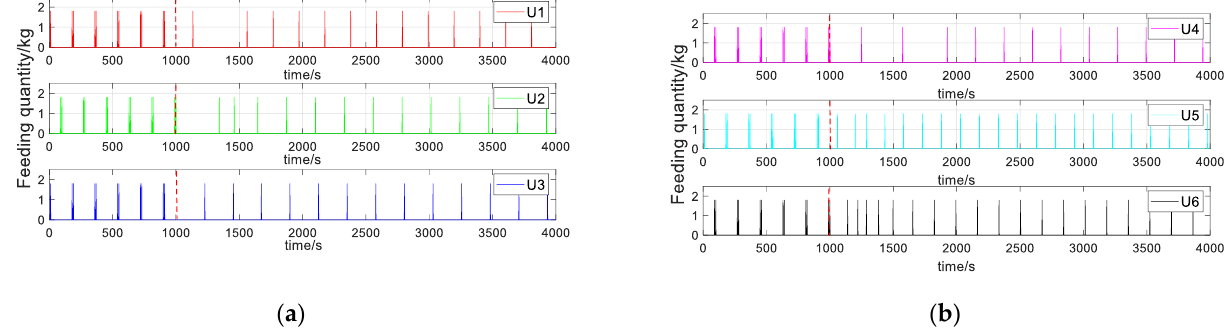
Figure 9. Distributed feeding interval control: ( a ) subsystems 1 – 3; ( b ) subsystems 4 – 6.